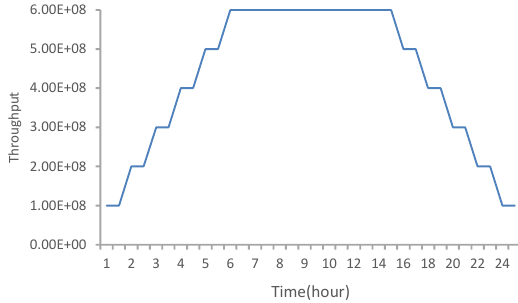
Figure 10. Throughput of the data center per day.